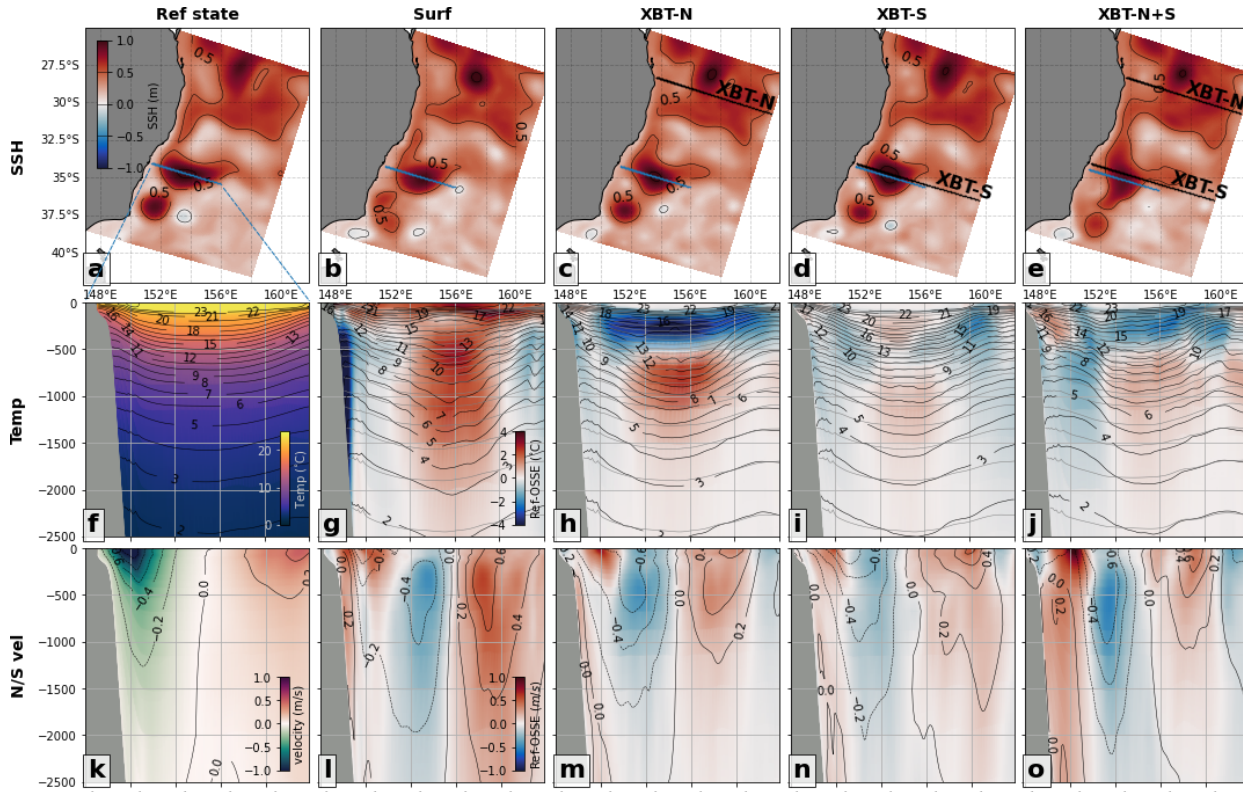
Figure 6. The vertical representation of an anticyclonic eddy at ∼ 35 ◦ S, 153 ◦ E in the (a) Ref state is compared to the (b) Surf, (c) XBT-N, (d) XBT-S, and (e) XBT-N+S OSSEs, with the SSH field and vertical profile location marked by a blue line. The vertical temperature profile along the transect is shown for the (f) Ref state and the (g) Surf, (h) XBT-N, (i) XBT-S, and (j) XBT-N+S OSSEs. Likewise, (k–o) northward velocity profiles are shown for the same experiments. In the OSSE panels, the difference in temperature and velocity from the Ref state plotted in colour and contours of (dark colour) the OSSE and (light colour) the respective field in the Ref state are shown for comparison. In panel (a) , the blue dashed lines indicate the transect shown in (f) . The XBT-N and XBT-S transect locations are marked in the respective panels. Axes with latitudes are labelled ◦ S, and axes with longitudes are labelled ◦